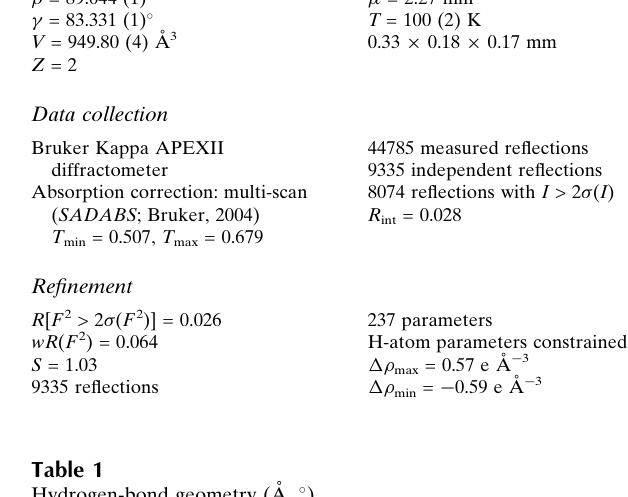
Hydrogen-bond geometry (A˚ , (cid:1)